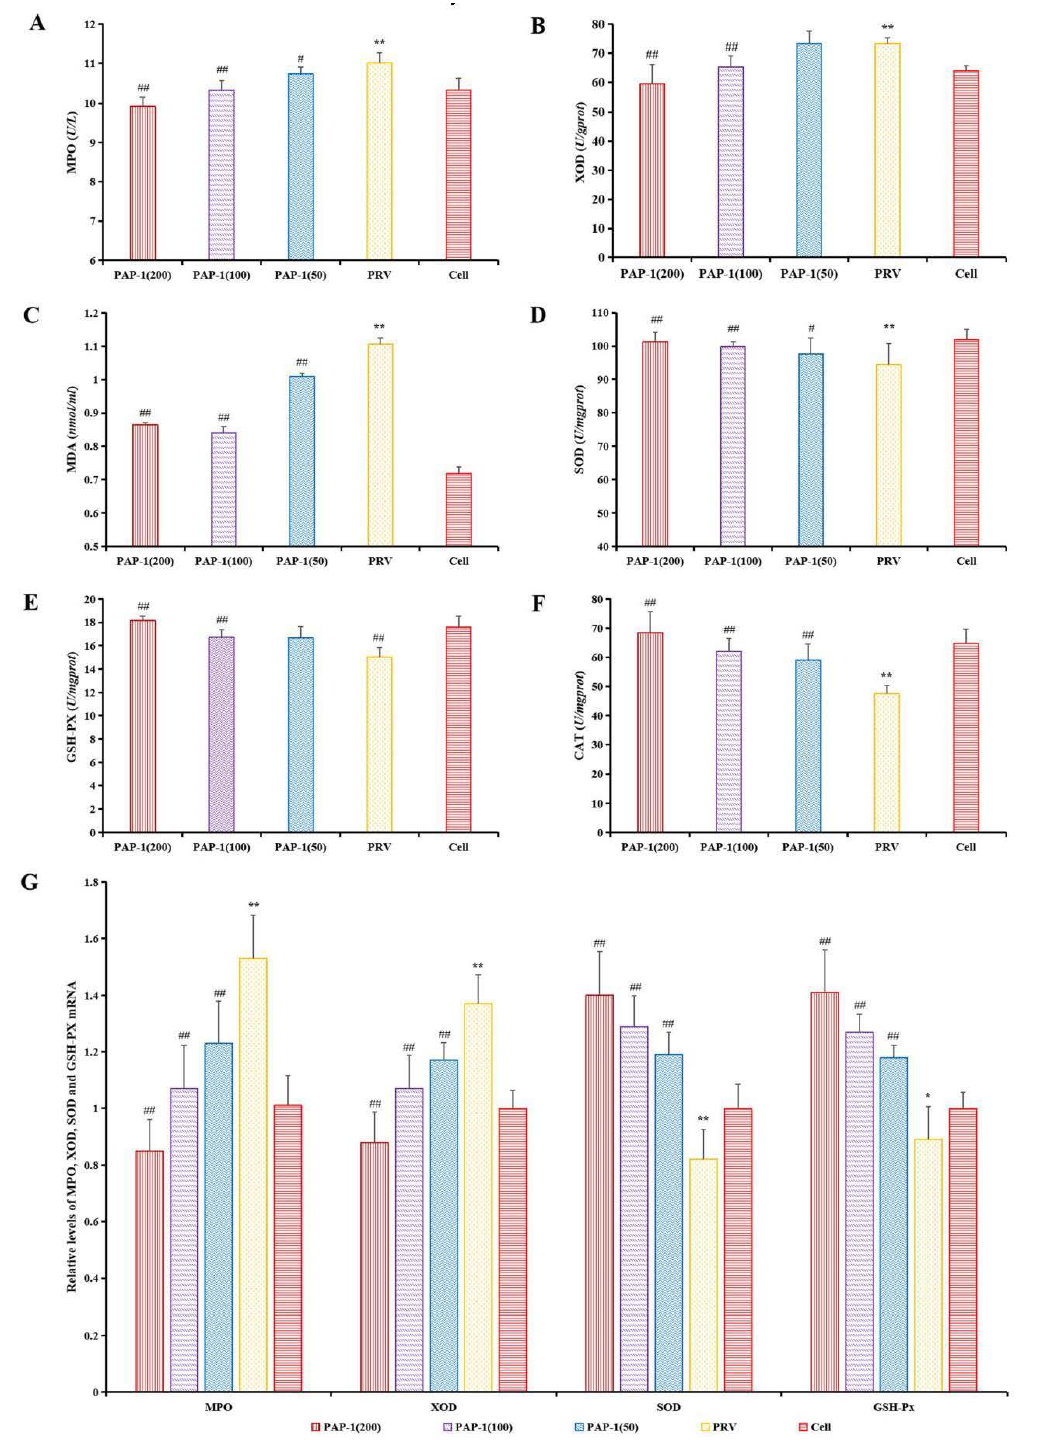
Figure 7. The effect of PAP-1 on the antioxidant activity of PRV-infected RAW264.7 cells. ( A ) The activity of MPO; ( B ) The activity of XOD; ( C ) The level of MDA; ( D ) The activity of SOD; ( E ) The activity of GSH-Px; ( F ) The activity of CAT; ( G ) Relative levels of MPO, XOD, SOD, and GSH-Px mRNA. (means ± SD, n = 9). Bars with * and # indicate a significant difference between the cell group and the PRV group ( p < 0.05). ** and ## show the most significant differences with the cell group and PRV group, respectively ( p <